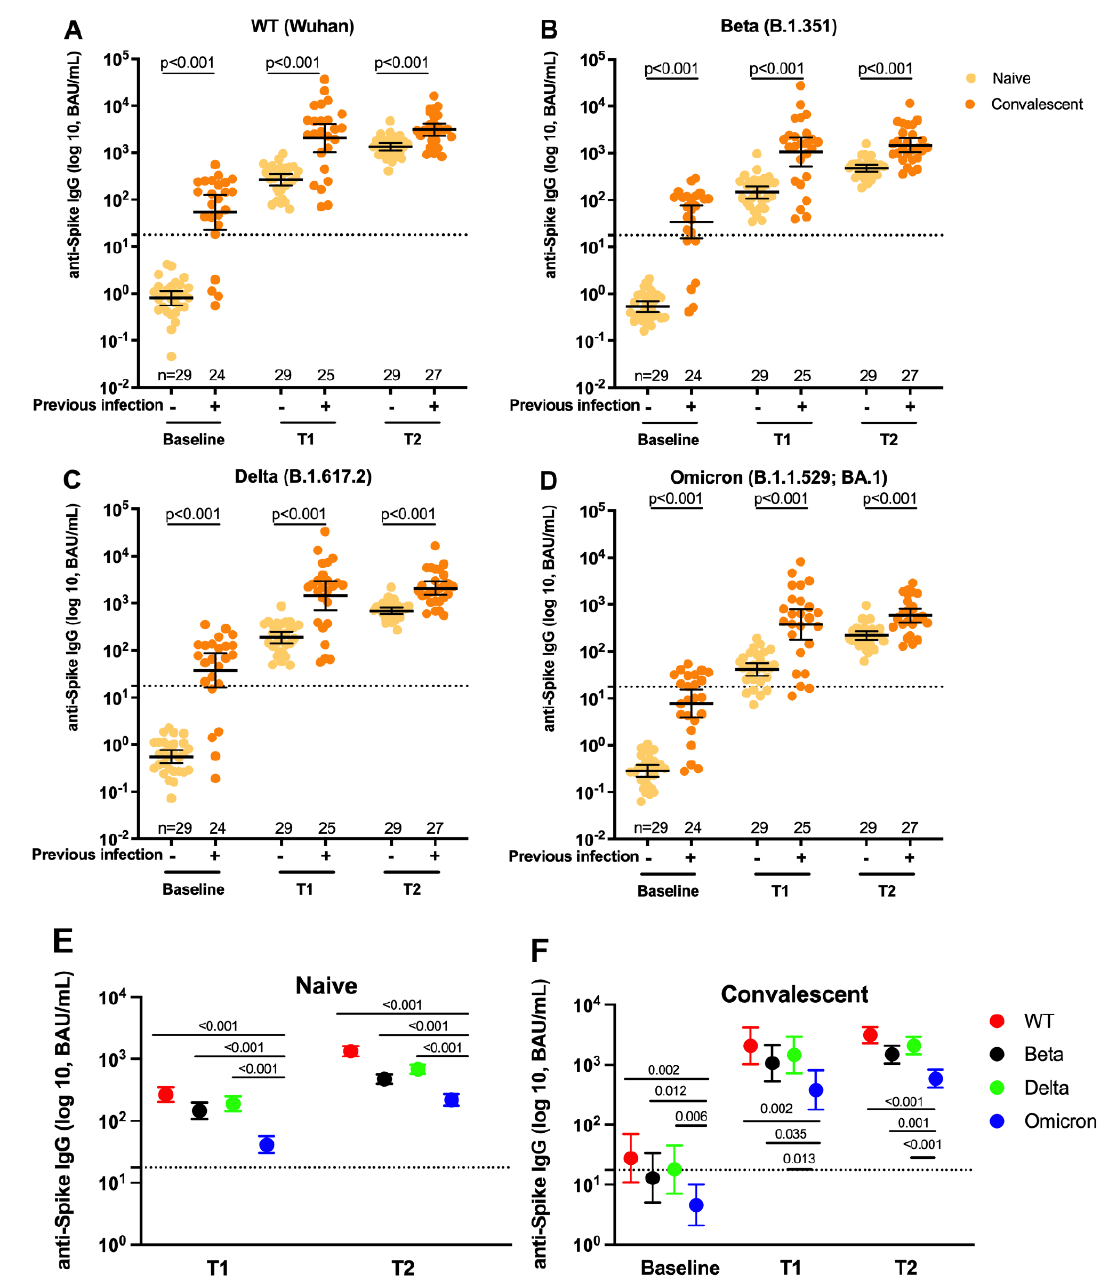
Figure 1. Plasma anti-spike antibody levels against SARS-COV-2 variants, in infection-naïve and convalescent individuals vaccinated with BNT162b2 over time. ( A–D ) . Scatter dot plots showing the geometric mean with 95% confidence intervals of the anti-spike IgG levels against Wildtype ( A ), against Beta ( B ), against Delta ( C ), and against Omicron ( D ) at baseline, T1 and T2 in infection-naïve (yellow dots) and convalescent individuals (orange dots). The dash lines represent the assay cutoff at 17.66 BAU/mL. The solid bars correspond to the geometric mean with 95% CI. ( E , F ). Dot graphs showing the geometric means with 95% confidence intervals of anti-spike IgG levels against WT, Beta, Delta and Omicron at T1 and T2 in infection-naïve ( E) and at Baseline, T1 and T2 in convalescent individuals ( F ). Red dots represent WT anti-spike IgG levels; black dots represent Beta anti-spike IgG levels; green dots represent Delta; blue dots represent Omicron anti-spike IgG levels. Statistical analysis was performed with the 2-tailed nonparametric Mann – Whitney test for comparison between two groups with a p < 0.05 considered significant.